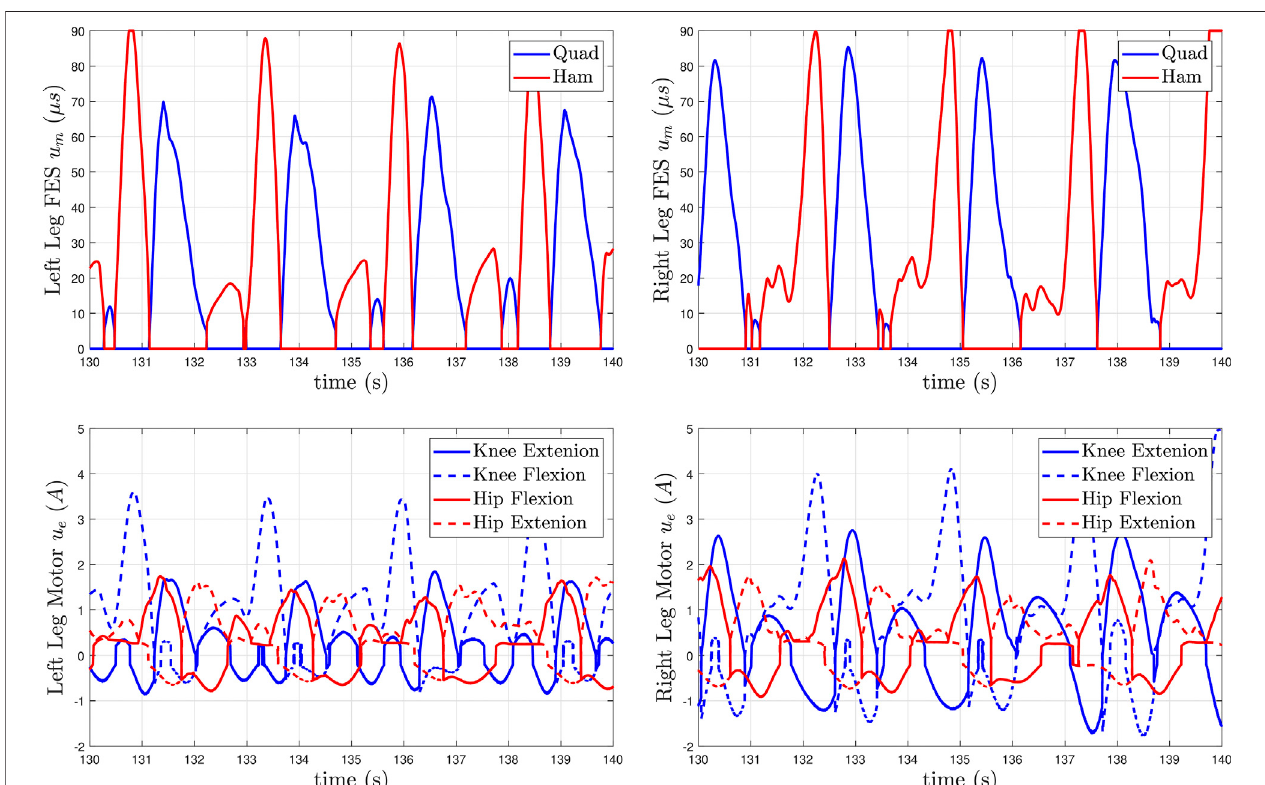
FIGURE9| DistributionofthemuscleandmotorcontrolinputsforSubject2(S2)duringthehighspeedwalkingtrial(0.8 mph).Thetopplotsdepictthepulsewidths generated by u m and applied to the quadriceps and hamstrings muscle groups for the left and right legs after 2 minutes of treadmill walking. The bottom plots show the motor currents generated by u e and applied to the motors that actuate the knee and hip joints of the left and right legs.